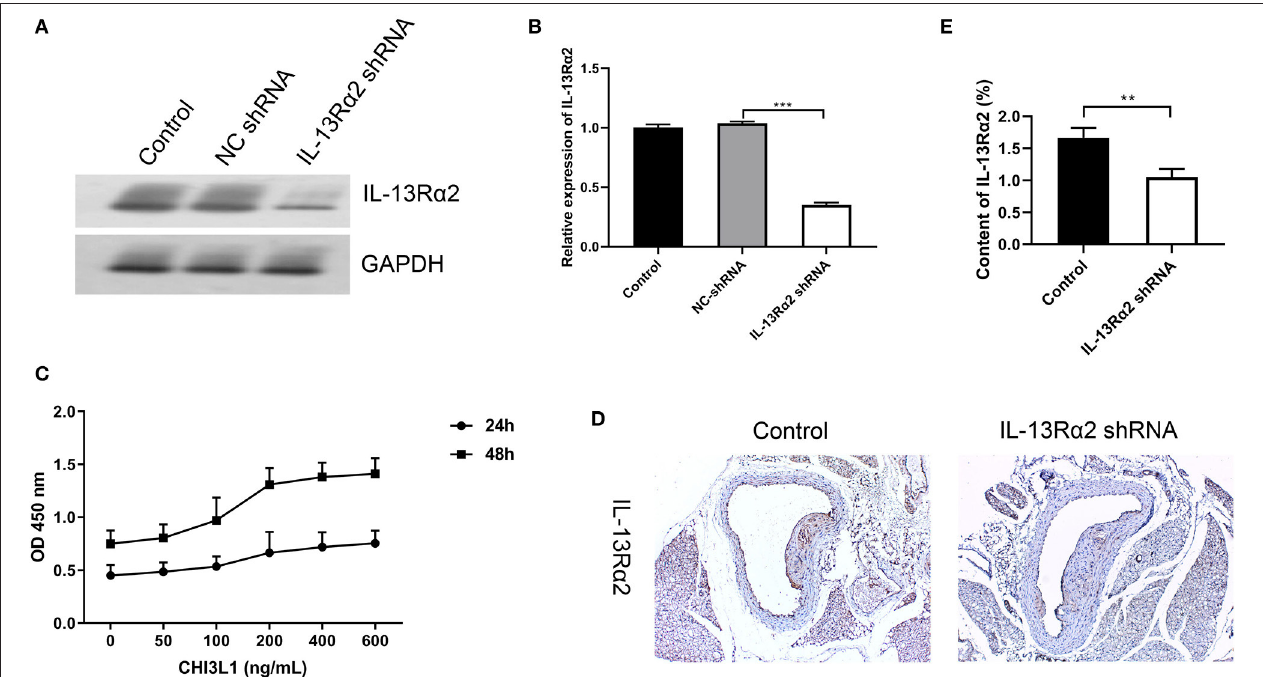
FIGURE 3 | Interference effect of Ad.IL-13R α 2 shRNA and optimal concentration of CHI3L1 for proliferation. Interference effect of Ad.IL-13R α 2 shRNA on membrane protein of IL-13R α 2 in human umbilical vein endothelial cells (HUVECs) measured by Western blotting (A,B) . The CCK-8 assay was performed to investigate the proliferation of HUVECs with different concentrations of CHI3L1 at 24 and 48h, respectively (C) . The inhibition effect of Ad.IL-13R α 2 shRNA on the expression of IL-13R α 2 in the aorta was analyzed by immunohistochemistry (D,E) . Data were presented as mean ± SD ( n = 3 per group). ** p < 0.01 and *** p <